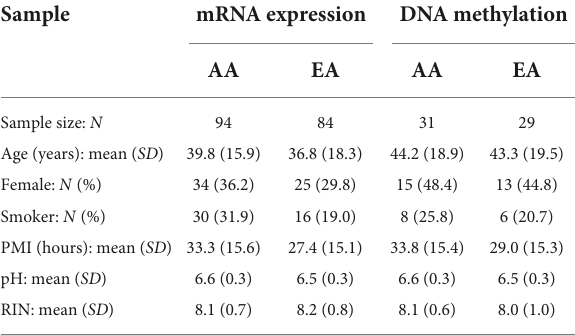
TABLE 1 Characteristics of study